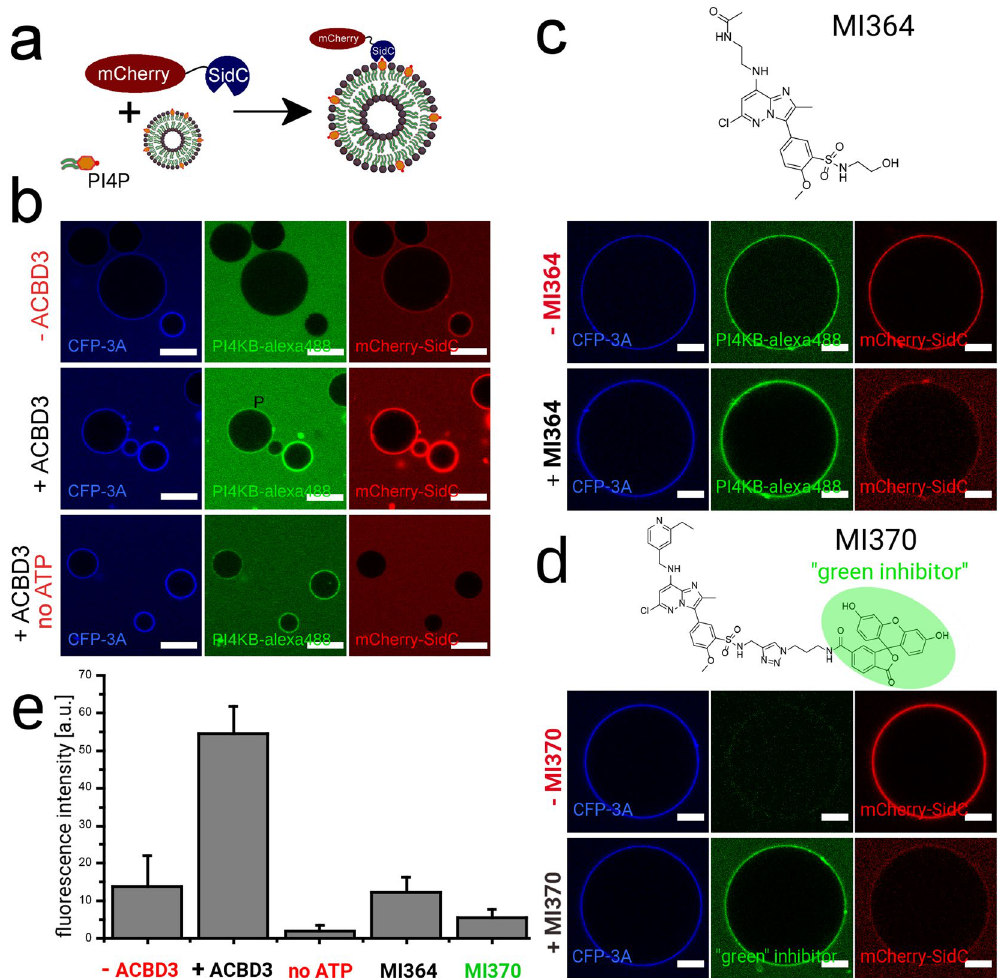
Figure 3. PI4KB is activated in the 3A:ACBD3:PI4KB protein complex. ( A ) Scheme of the experiment. A PI4P binding domain from the Legionella pneumonia SidC protein that binds to PI4P with nanomolar affinity was fused to mCherry and used as a fluorescent PI4P biosensor. ( B ) Production of PI4P on the surface of GUVs. Upper panel: GUVs decorated with the viral 3A-CFP protein (250 nM) were incubated with Alexa488 labeled PI4KB (250 nM) and SidC-mCherry (100 nM) and imaged using a confocal microscope. Middle panel: As above but also ACBD3 (250 nM) was also added. Lower panel: As the middle panel but no ATP was added. The CFP-3A signal is in blue, the PI4KB-Alexa488 signal in green and the mCherry-SidC signal is in red. Representative image of three independent experiments. Scale bar = 20 µ m. ( C ) Inhibition by the compound MI364. On the top is the chemical structure of MI364. On the bottom is a representative image of GUVs phosphorylated by Alexa488 labeled PI4KB (upper panel: without MI364, lower panel: with 5 µ M MI364). The CFP-3A signal is in blue, the PI4KB-Alexa488 signal in green and the mCherry-SidC signal is in red. Representative image of three independent experiments. Scale bar = 10 µ m. ( D ) Inhibition by the fluorescent compound MI370. On the top is the chemical structure of MI370 (the fluorescent part in highlighted in green). On the bottom is a representative image of GUVs phosphorylated by unlabeled PI4KB (upper panel: without MI370, lower panel: with 5 µ M MI370). The CFP-3A signal is in blue, the MI370 signal in green and the mCherry-SidC signal is in red. Representative image of three independent experiments. Scale bar = 10 µ m. ( E ) Quantification of PI4P production. Quantification of the intensity of fluorescence of the SidC-mCherry PI4P biosensor on the surface of GUVs was. Standard deviations are based on three independent